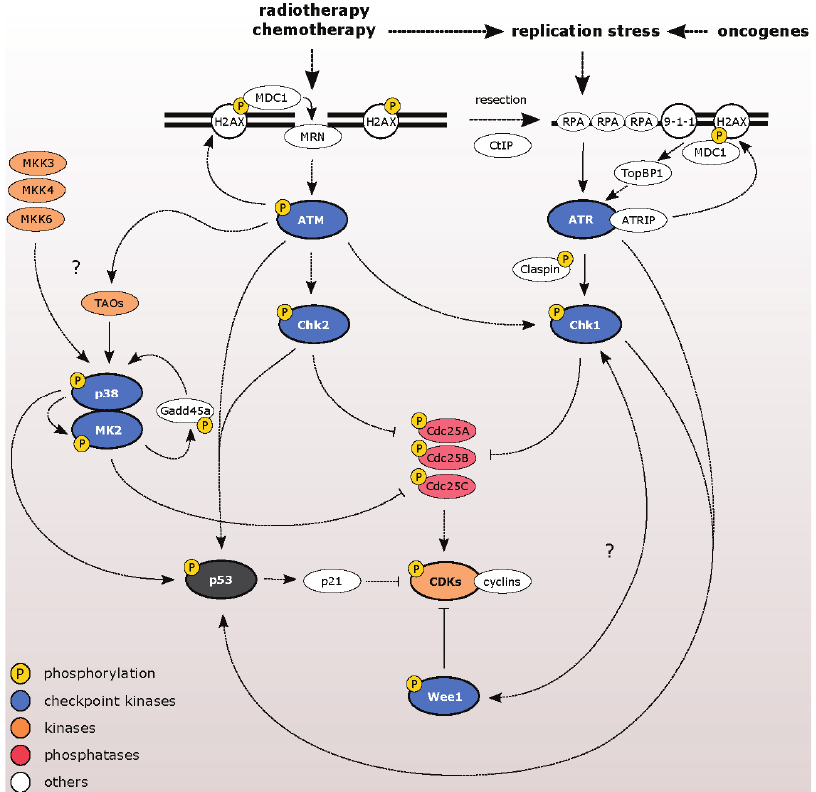
Figure 1. DNA damage response activates cell cycle checkpoint. Cell cycle progression is controlled by CDKs that are inactivated by Wee1 kinase and activated by Cdc25A/B/C phosphatases. Induction of DSBs activates ATM/Chk2 pathway, while exposed ssDNA initiates the ATR/Chk1 pathway. Both pathways inactivate Cdc25A/B/C leading to a temporal cell cycle arrest. Activation of p53/p21 pathway is crucial for the G1 checkpoint. The activation of the p38MAPK/MK2 pathway contributes to the checkpoint activation and